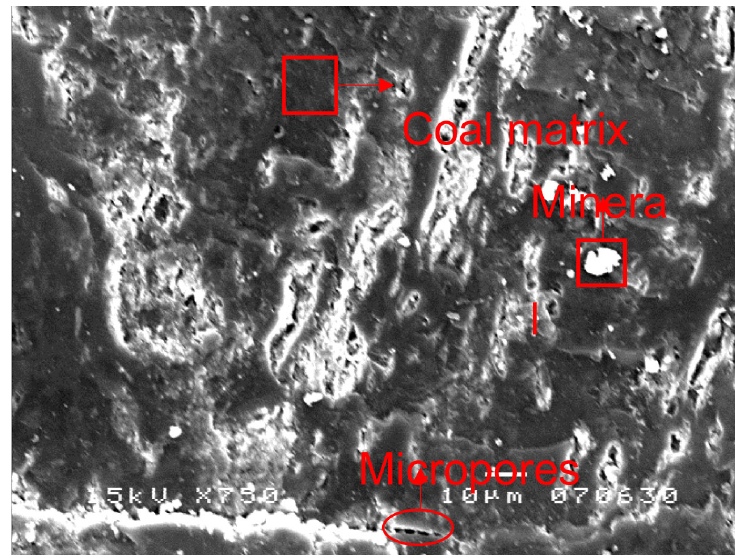
Fig. 5 Backscattered electron (BSE)–scanning electron microscopy image of the No. 8